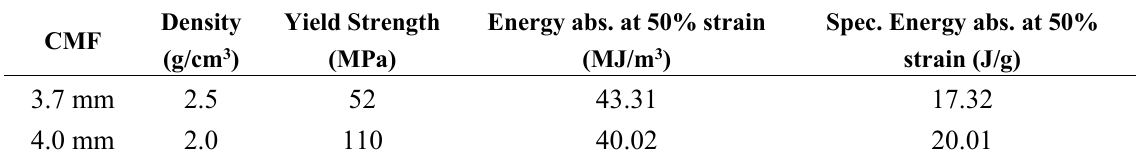
Table 5. Yield strength and energy absorption in Al-S CMF samples made with for 3.7 mm and 4.0